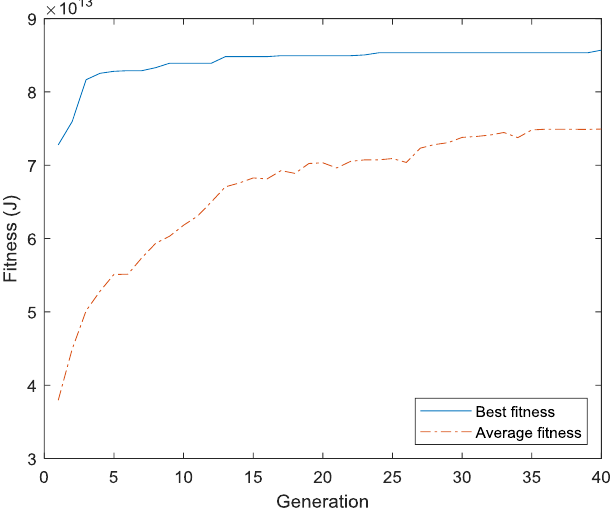
Energies 2019 , 12 , x Figure 9. The convergence process of the GA in well-placement optimization. Figure 9. The convergence process of the GA in well-placement optimization.